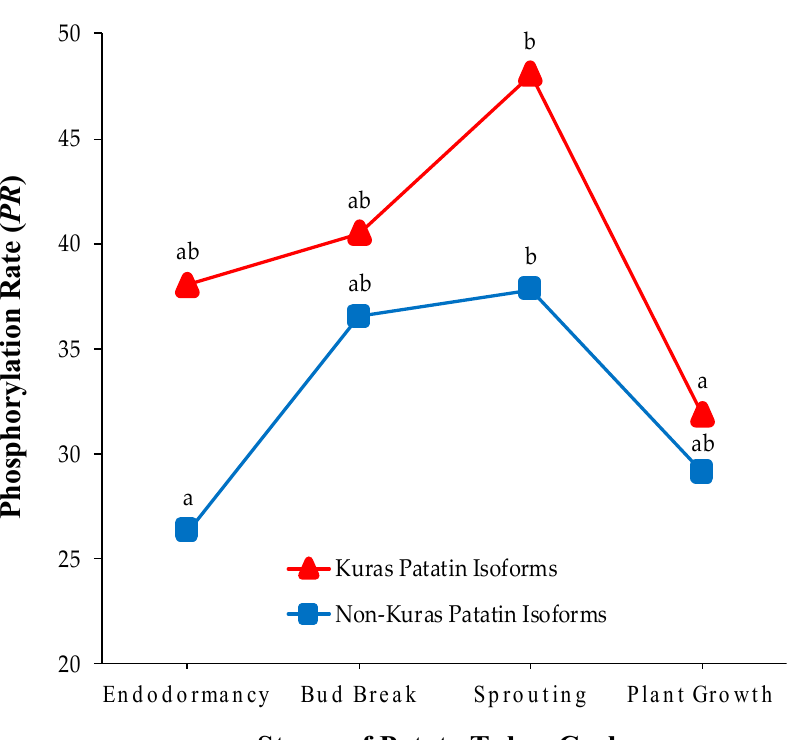
Figure 4. Temporal changes in the phosphorylation status of Kuras and non-Kuras patatin isoforms in the different stages of the potato tuber life cycle: endodormancy, bud break, sprouting and plant growth. Values on the y-axis are means of PR computed from four biological replicate gels over Kuras (triangles) and non-Kuras (squares) patatin spots. Different lower case letters (a and b) indicate statistically significant differences ( p < 0.05) between sample groups by the post hoc Tukey-Kramer test following the one-way ANOVA test.